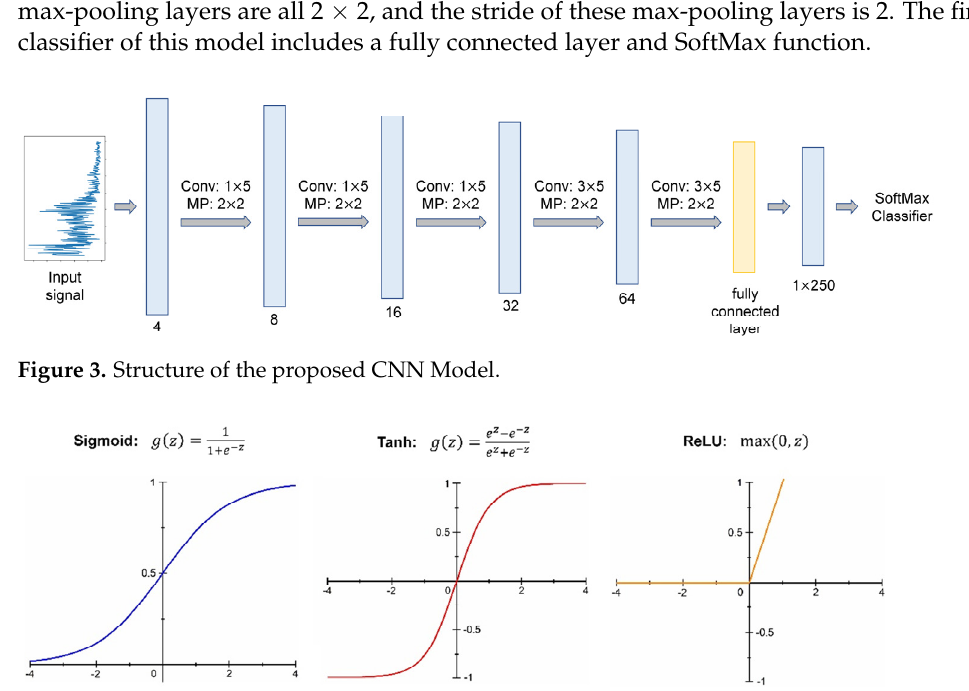
Figure 3. Structure of the proposed CNN Model.